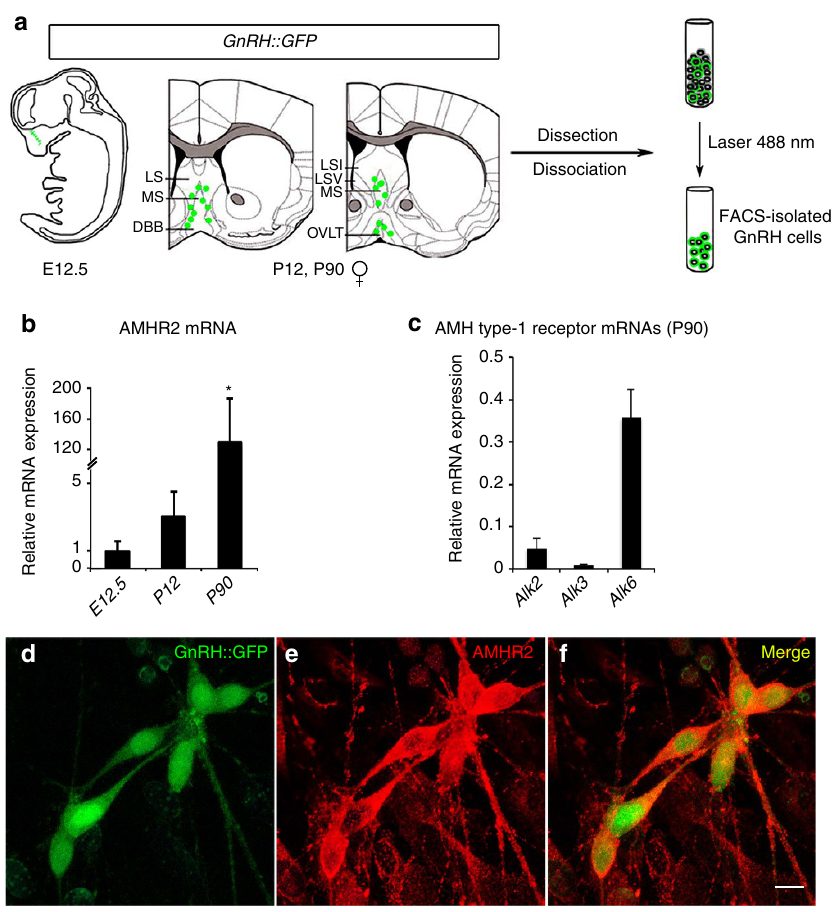
Figure 3 | AMH receptor transcript expression in GnRH neurons. ( a ) Schematic summarizing the isolation of GnRH-GFP cells. GFP-positive GnRH neurons were isolated by fluorescence-activated cell sorting from the nasal region of E12.5 embryos ( n ¼ 3) and from the hypothalamic preoptic area of postnatal (females P12, n ¼ 3) and adult (females P90, n ¼ 3) female mice. ( b ) Real-time PCR analysis of expression levels of AMHR2 messenger RNA (mRNA) in GnRH cells sorted at E12.5, P12 and P90. AMHR2 transcript expression was detectable in GnRH neurons at all stages, although it reached its highest level at P90. Values are expressed relative to values at E12.5, set at 1, and shown as means ± s.e.m. One-way analysis of variance, F (2,8) ¼ 7.6, P ¼ 0.02. Fisher’s least significant difference post hoc test, *: P o 0.05 between P90–P120 and E12.5 and P90–P120 versus P12. ( c ) Relative mRNA expression of AMH type-I receptors ( Alk2 , Alk3 and Alk6 ) in GnRH neurons isolated from the preoptic region of adult female mice (females P90, n ¼ 3). All receptor transcripts were detectable in adult GnRH neurons. ( d – f ) Nasal explants were generated from E11.5 GnRH-GFP embryos ( n ¼ 7) and maintained in serum-free media for 7 days before immunohistochemistry procedures. Immunostaining for AMHR2 show co-localization with fully differentiated GnRH- GFP neurons. Experiments were replicated three times. LS, lateral septum; MS, medial septum; DBB, diagonal band of Broca; LSI, lateral septal nucleus, intermediate part; LSV, lateral septal nucleus, ventral part; OVLT, organum vasculosum of the lamina terminalis. Scale bars, ( d – f ) 10 m